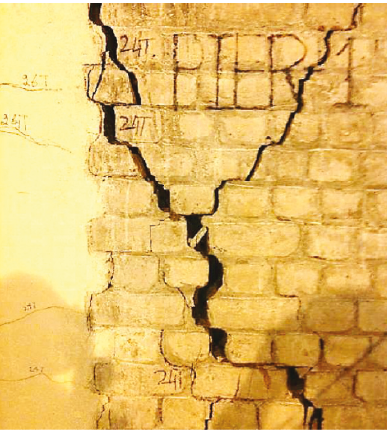
Figure 8: Diagonal shear cracks showing a scissor pattern corre- sponding to story drift of 0.73%.